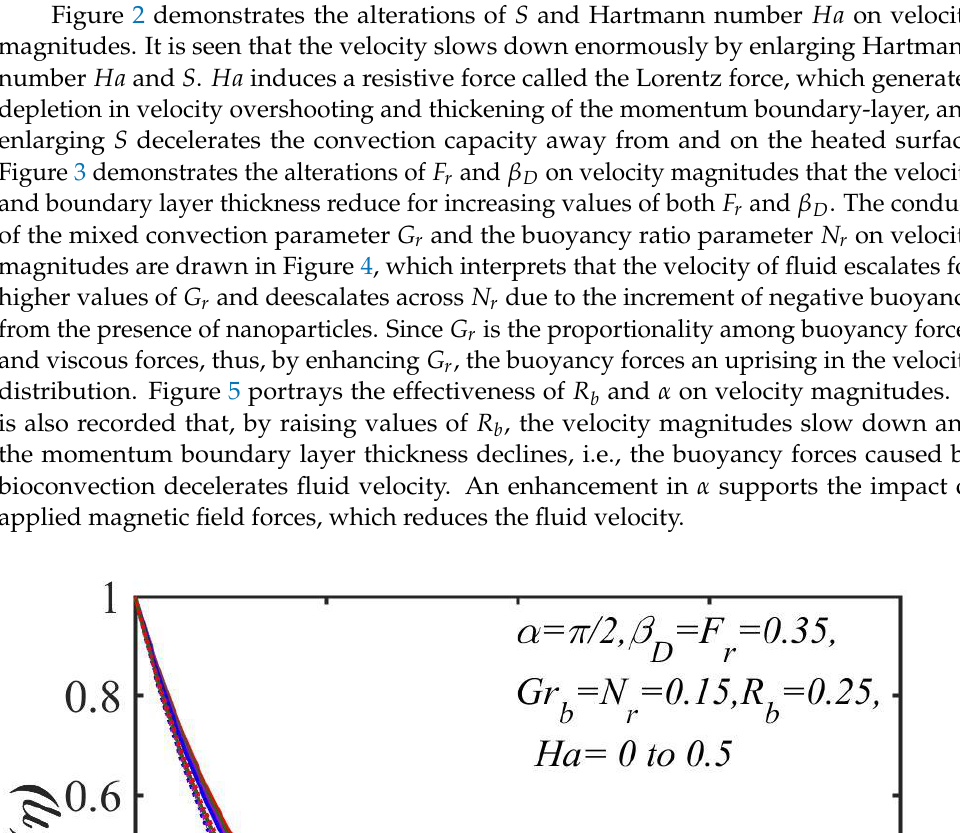
Figure 3. Variation of 𝐹 𝑟 and 𝛽 𝐷 on velocity magnitudes. Solid curve: 𝛽 𝐷 = 0.25 ; dotted curve: 𝛽 𝐷 = 1.25 .